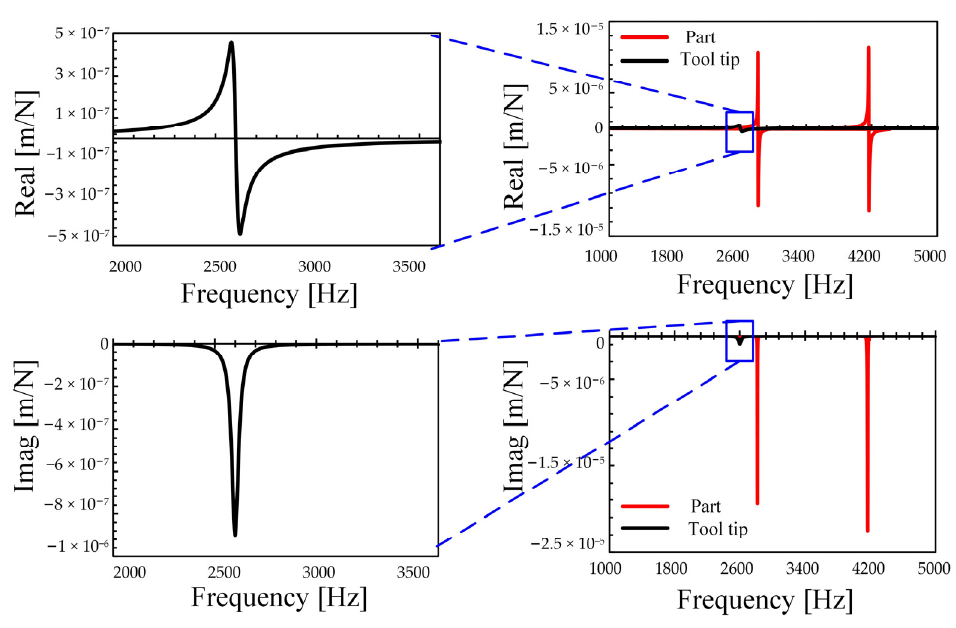
Figure 9. FRFs’ comparison between part and tool tip.